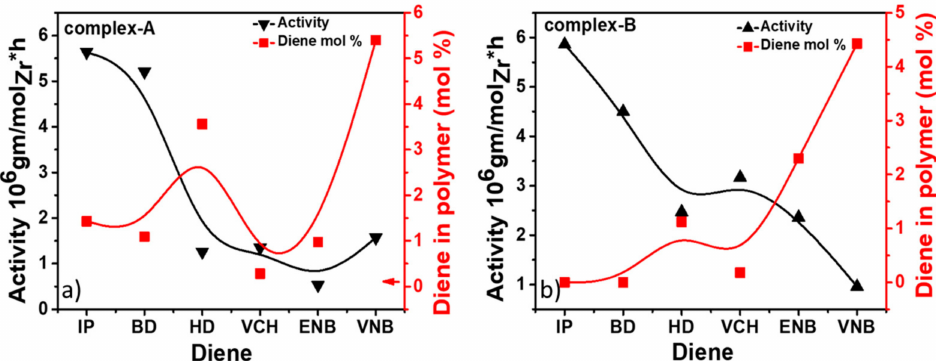
Figure 7. Variation of activity profile and diene content in ethylene/propylene/diene with ( a ) complex A and ( b ) complex